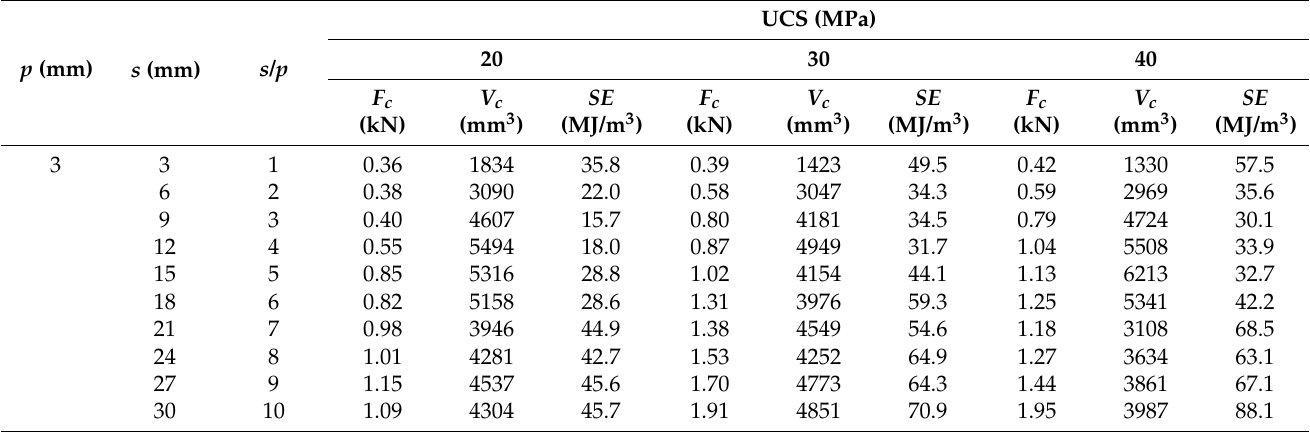
Table 6. Mean cutting force, cutting volume, and SE for various cutting